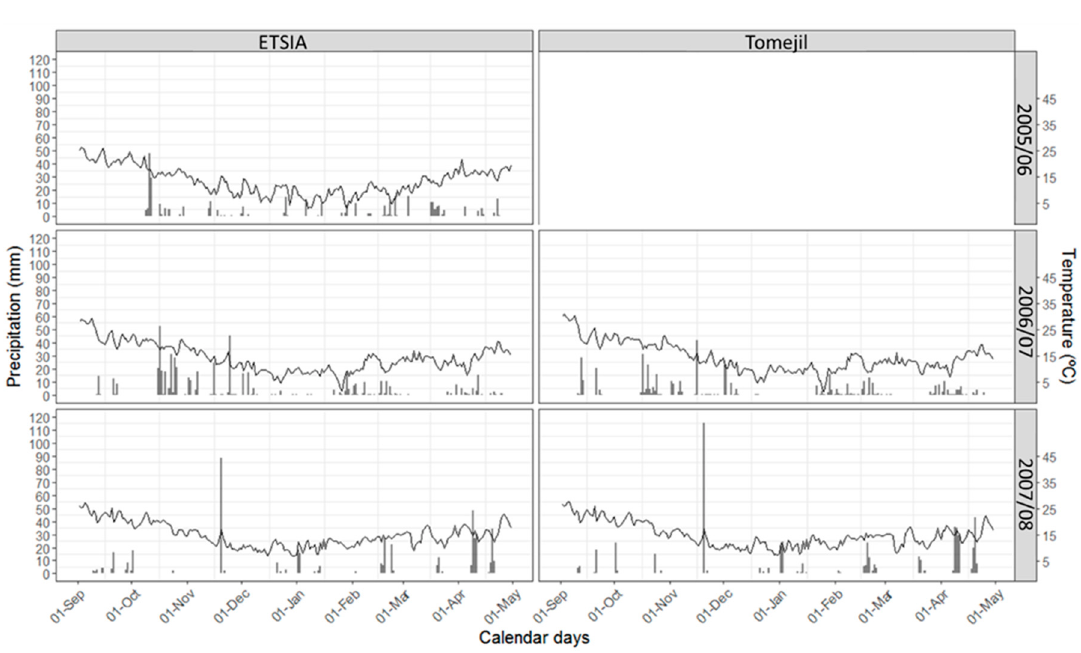
Figure 1. Daily mean air temperatures (lines) and daily precipitation (bars) at each experimental location.